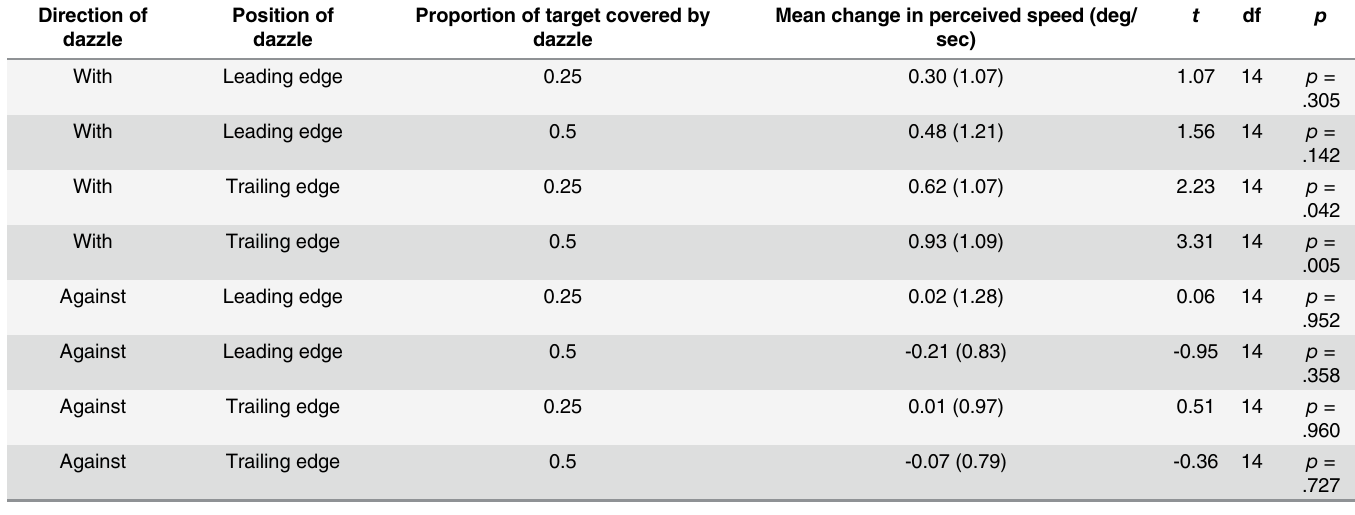
Table 2. Experiment 3: Mean ( ± SD) change in perceived speed, compared to static dazzle control, and one-sample t -test results for different com- binations of dazzle size and position. Direction of dazzle